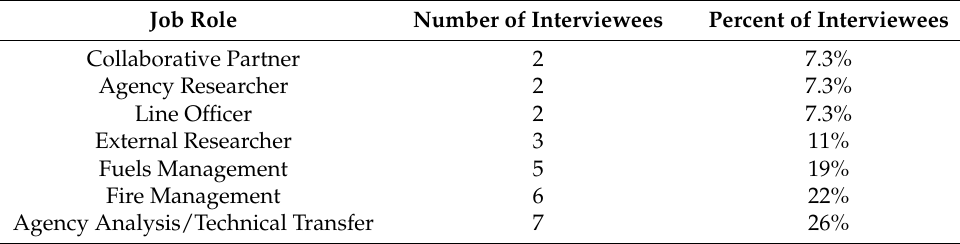
Table 3. Interviewee demographics by job